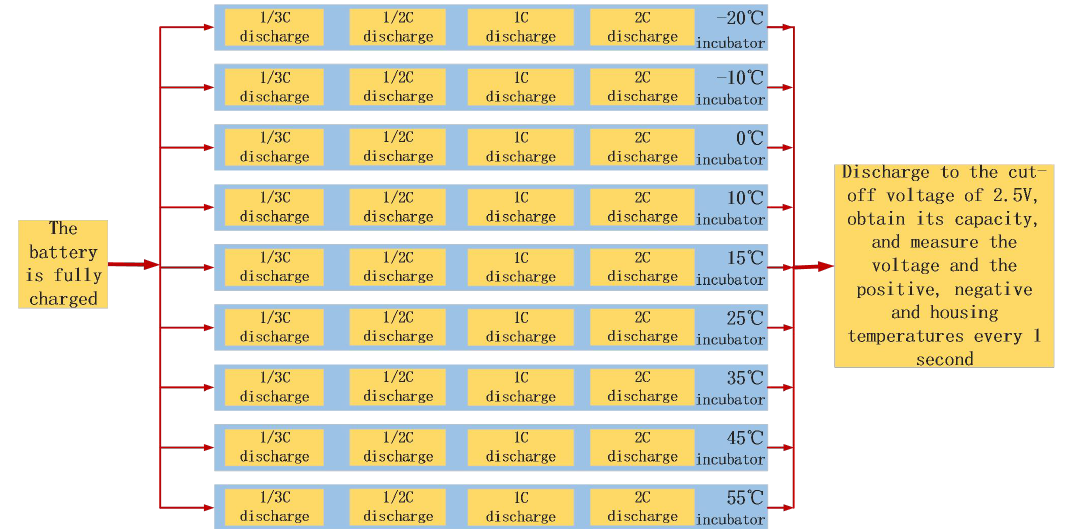
Figure 5. Variation of capacity and energy of battery with ambient temperature and charging rate. Generally speaking, under the discharging rate of an electric vehicle, the capacity change is closely related to the self-generated heat [28]. There will still be a temperature differential between the center temperature and the surface temperature, even when a very high convective cooling rate is used to maintain the temperature of the battery [12]. Therefore, the ambient temperature cannot characterize the temperature of the battery precisely. Based of the above limitations, in order to keep the measured temperature close to the internal temperature of the battery as much as possible, this paper takes the average temperature on the positive pole, negative pole, and shell of the battery, at each time as the approximate temperature of the whole battery. We used the battery capacity at 25 ° C and 1C discharging as the benchmark to obtain the capacity efficiency of the battery. The curve of capacity efficiency-battery temperature is shown in Figure 6.